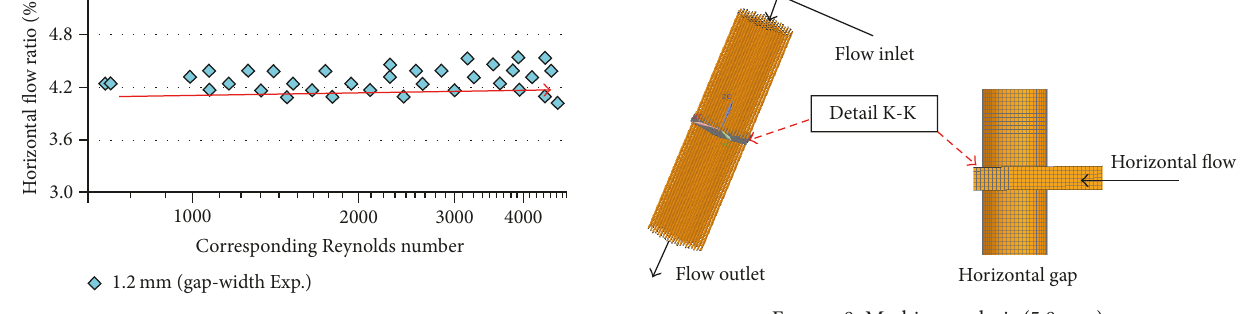
Figure 6: Horizontal flow ratio versus Reynolds number at 1.2 mm.